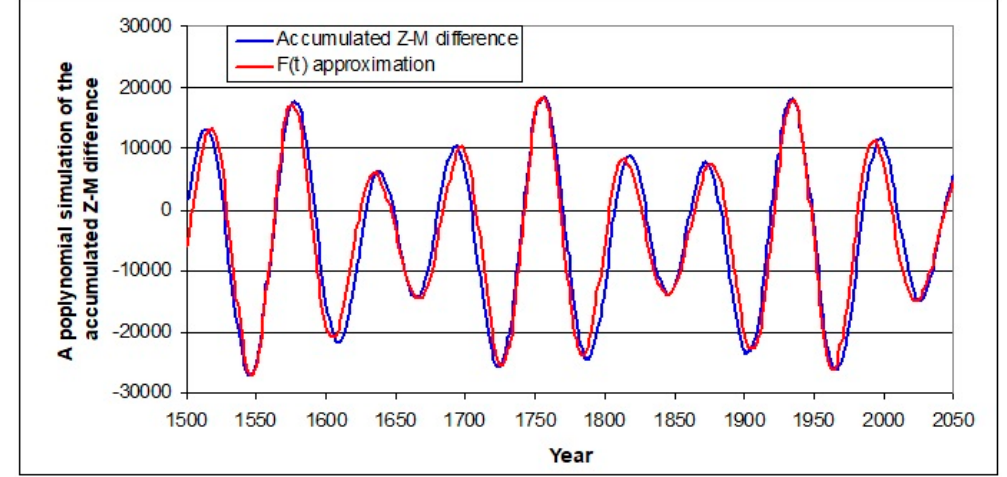
Figure 2. The accumulated annual Z-M difference from 1500 to 2100 with an eight-year lag, and an analog incorporating the F(t) function.